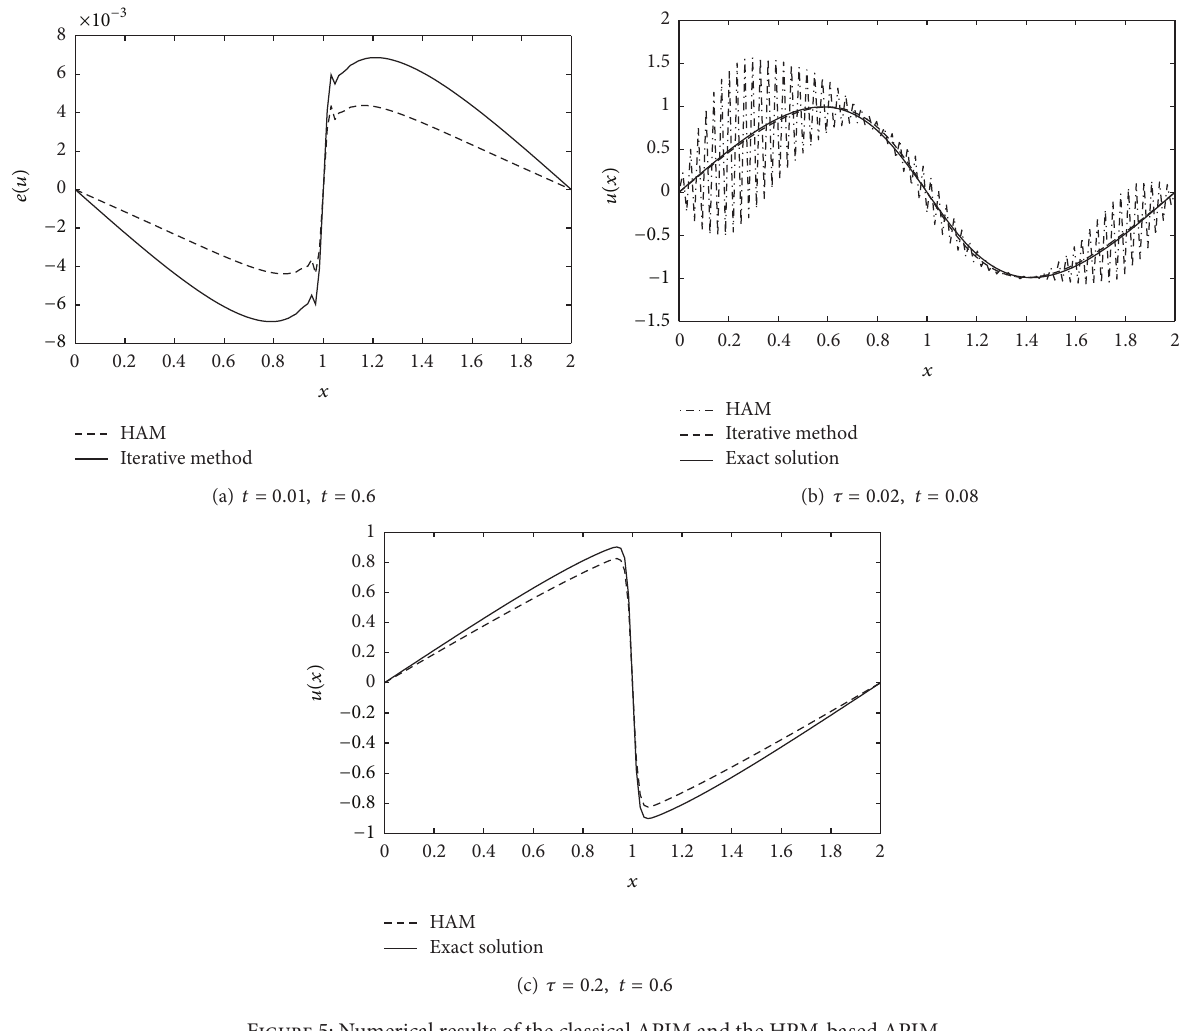
Figure 5: Numerical results of the classical APIM and the HPM-based